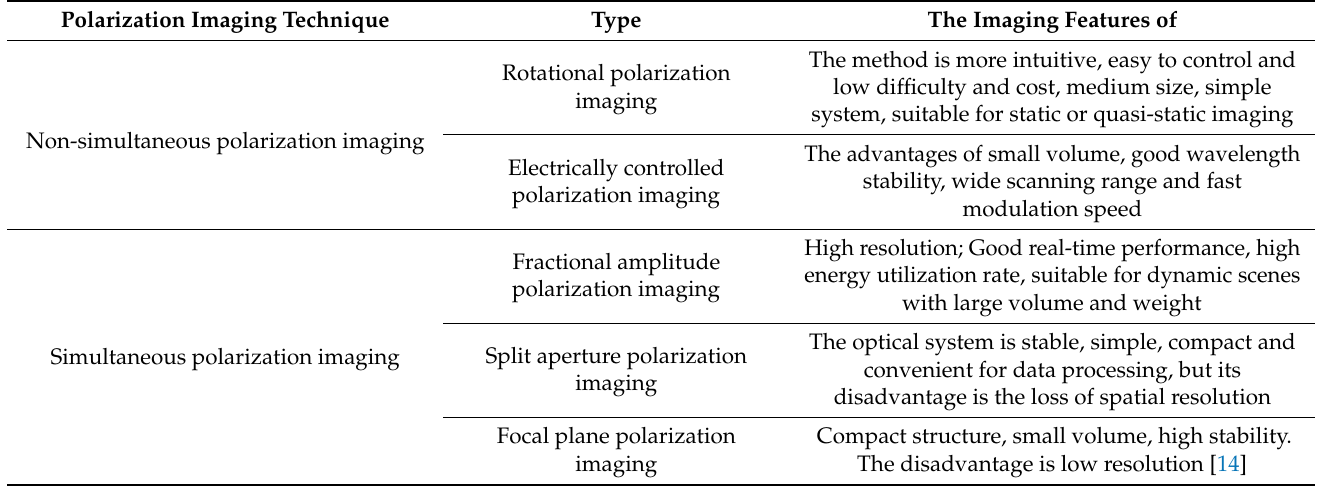
Table 1. Characteristics of time-sharing/simultaneous polarization imaging technology